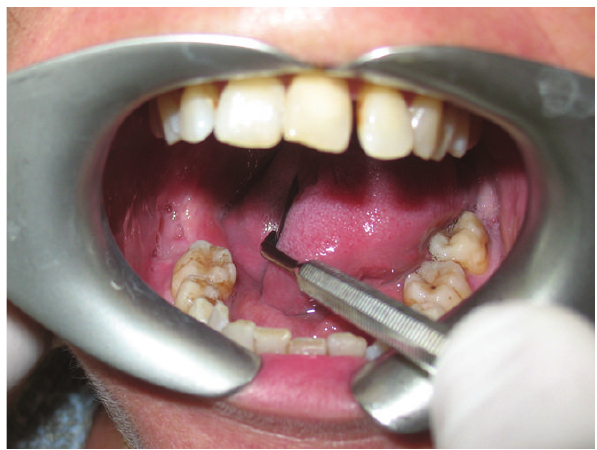
Figure 5: Three months clinical follow-up showed complete healing of the molar area.